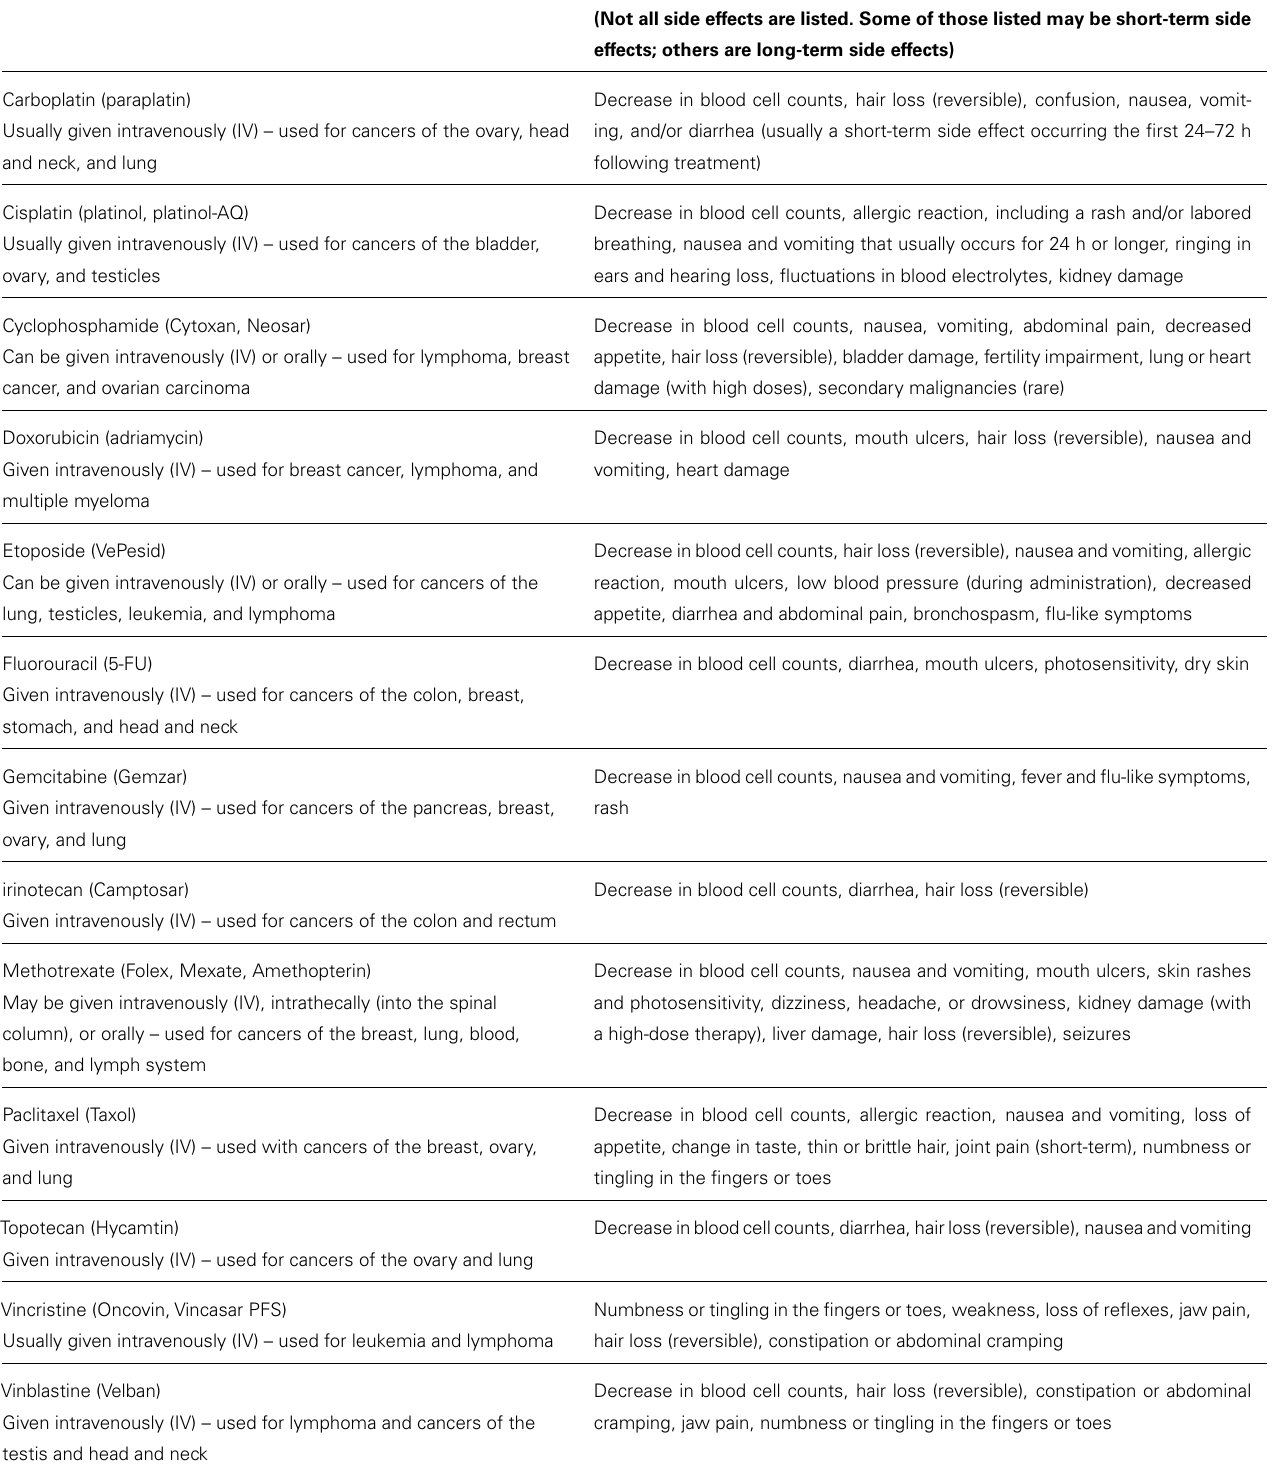
Table 1 |A list of commonly used cytotoxic chemotherapy drugs that block DNA metabolism or cell division (mitosis) along with their most common clinical indications and side effects (NCCN.com, the National Comprehensive Cancer Network) ®